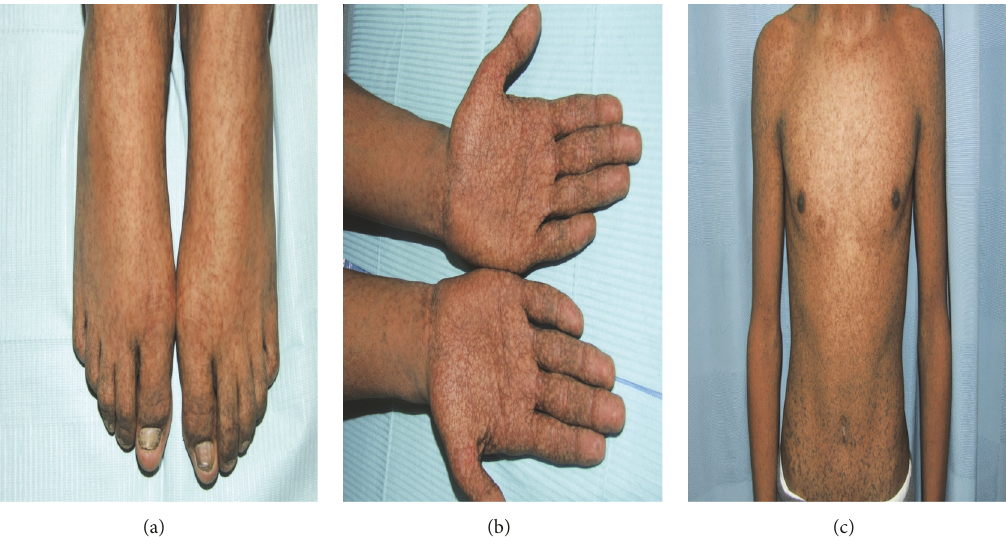
Figure 5: Dermatopathia pigmentosa reticularis: extensive hyperpigmentation in a reticulated pattern is noted on the dorsal aspect of the feet and the palms ((a)-(b)). Persistent reticulated hyperpigmentation that is widespread over the trunk